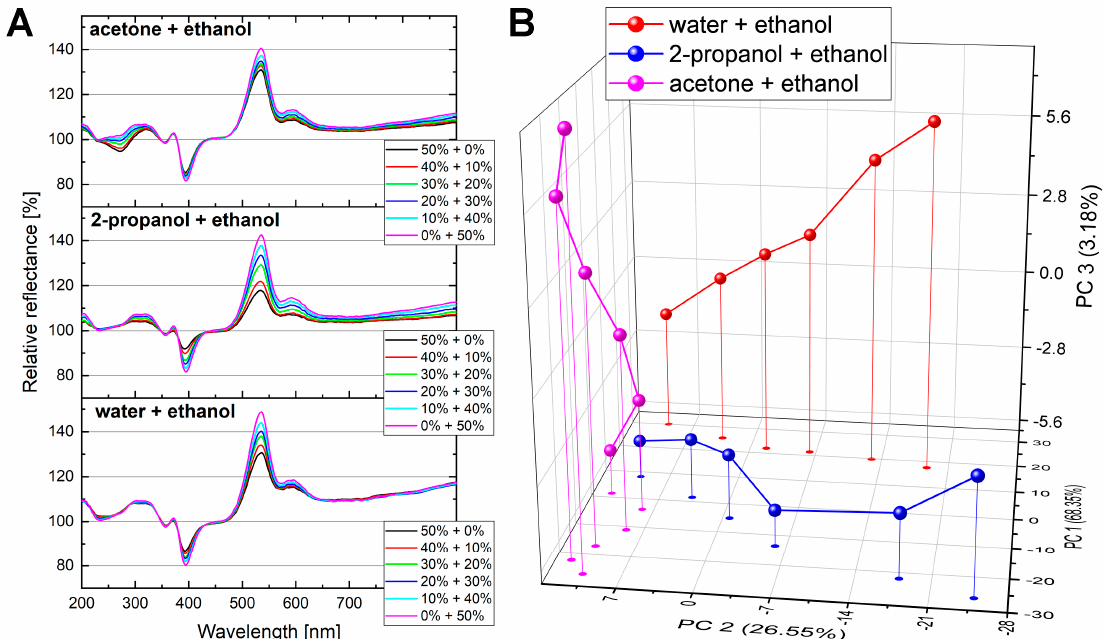
Figure 5. Different vapor mixtures generated different optical responses of the wing of a H. polycletus male specimen. Acetone + ethanol, 2-propanol + ethanol, and water + ethanol mixtures were applied. The concentration of the first saturated vapor component was set from 0% to 50%, while the second component was set adversely (50% to 0%). The whole mixture was also diluted with artificial air in a 1:1 ratio. ( A ) The optical responses (relative reflectances) of the three mixtures are characteristically different from each other. ( B ) The measured relative reflectances were analyzed using PCA. The PC scores plot shows the characteristic trajectories of the three mixtures. The three points close to each other on the left side are the points of the pure ethanol vapor from which the trajectories spread apart.